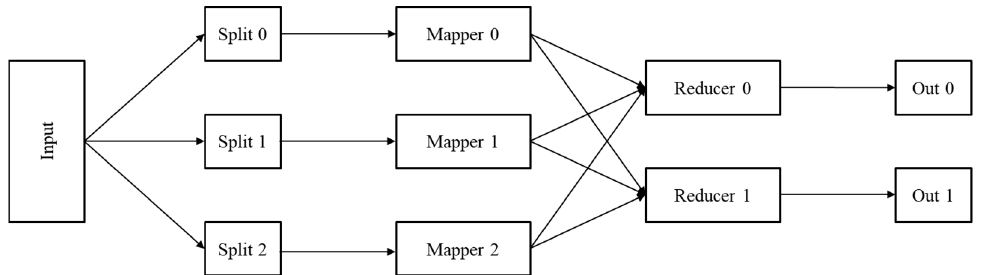
Figure 2. Hadoop MapReduce framework.